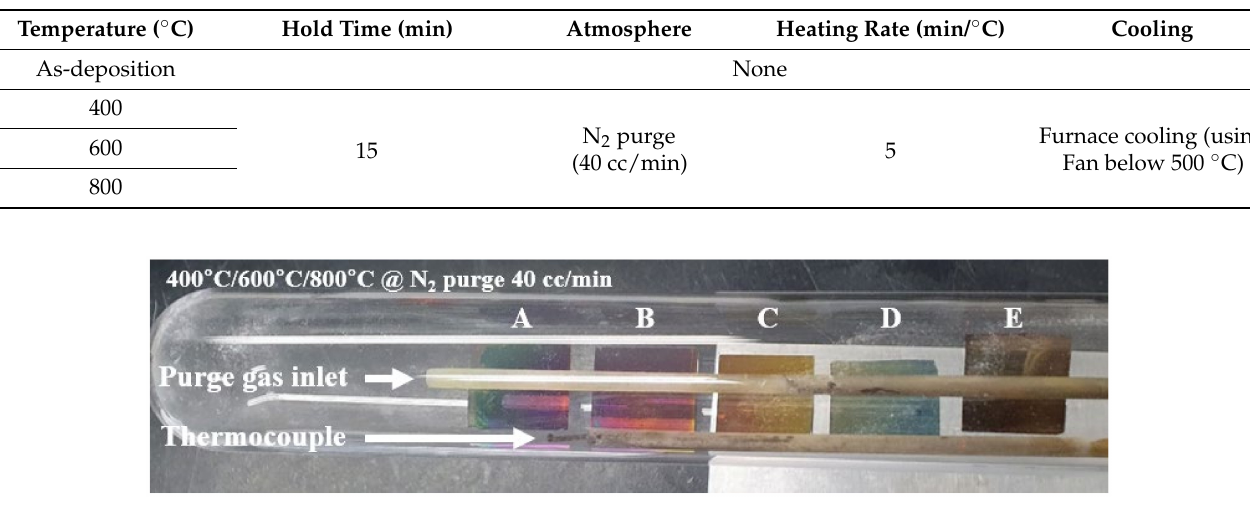
Table 1. Heat treatment test conditions.